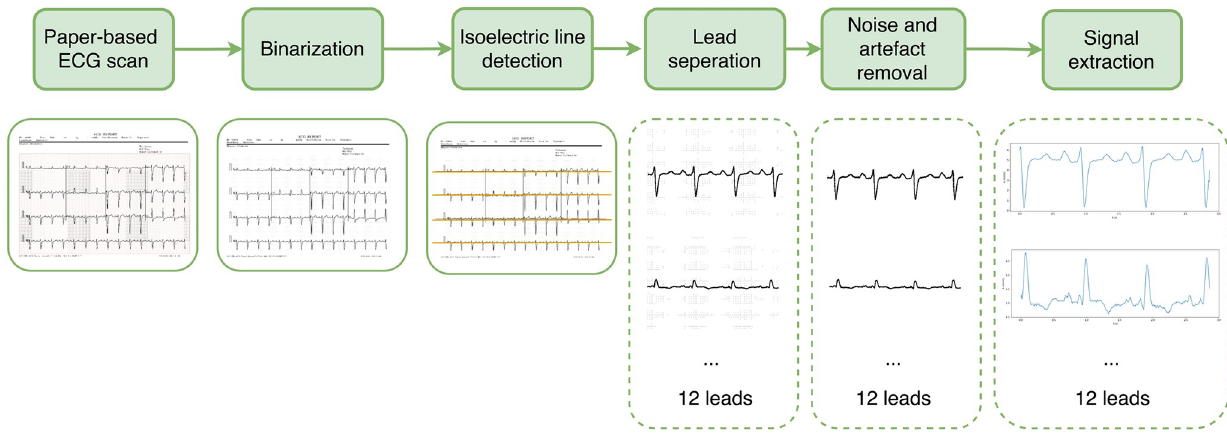
Fig 2. Procedure for converting paper-based ECG scans to 1D signals. The process of converting image to signal consists of 5 steps: image binarization, isoelectric line detection, lead separation, noise removal and signal extraction.